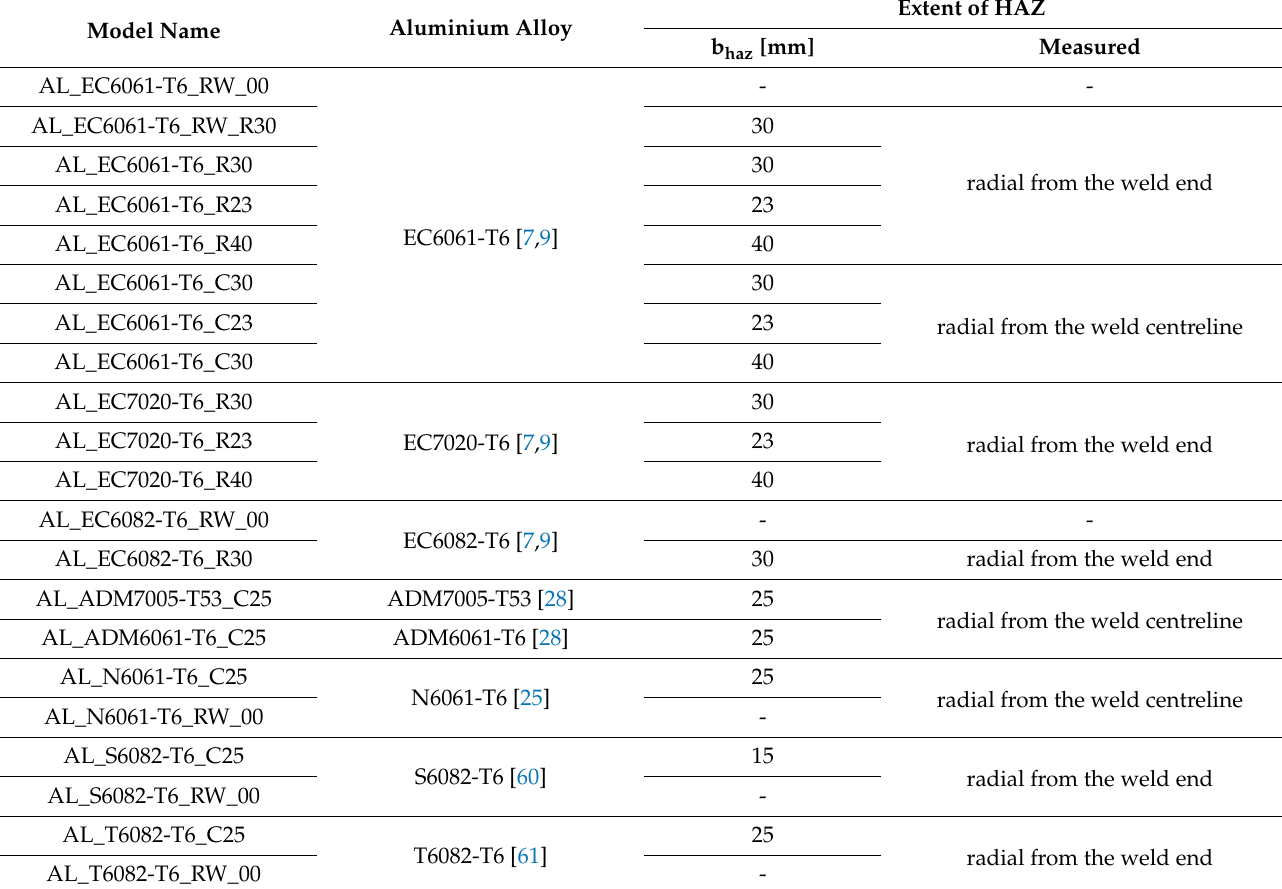
Table 2. Summary of analysed numerical models.